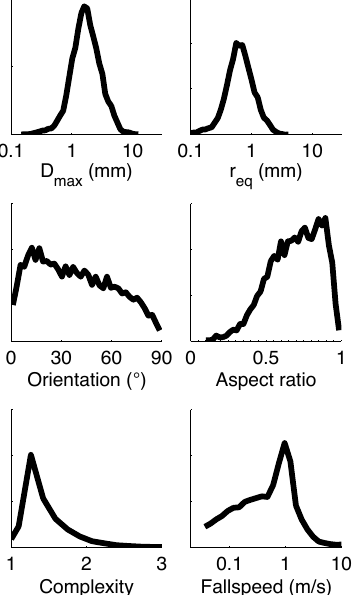
Fig. 3. MASC probability distributions (linear y-scale) based on approximately 10000 images obtained at Alta Ski Area. The di- mensionless representation of hydrometeor complexity is defined by the ratio of the hydrometeor perimeter to its equivalent cross- section circumference. For example, the complexity value is unity for a